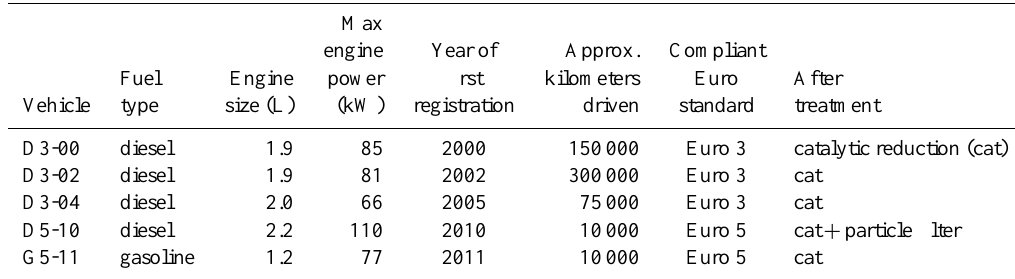
Table 1. Tested vehicle summary (D3-00 stands for Diesel powered Euro 3 compliant, made in 2000; G5-11 stands for Gasoline powered Euro 5 compliant, made in